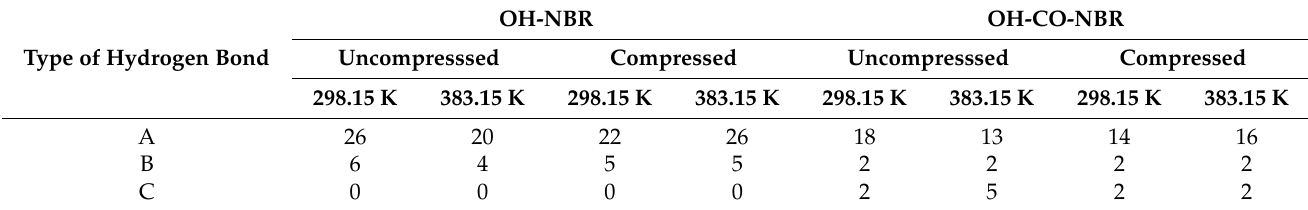
Table 3. The types and number of H-bonds in aged NBR models.